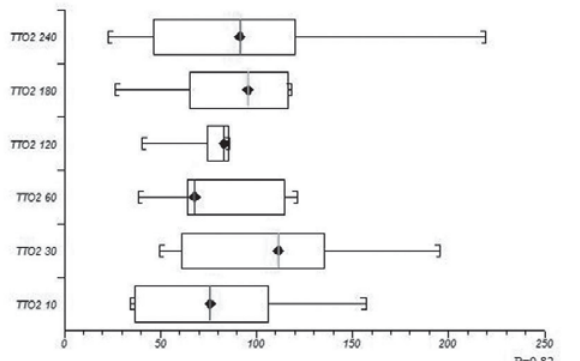
Fig. 1 – Taxa de transferência de oxigênio (TTO tempos de circulação